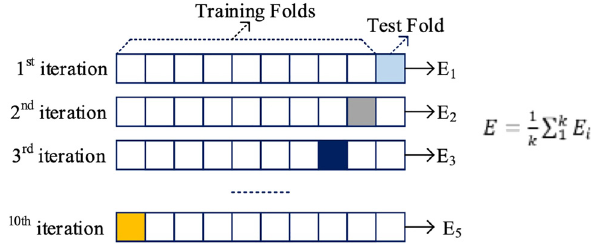
Figure 2: Implementation k-fold cross validation.